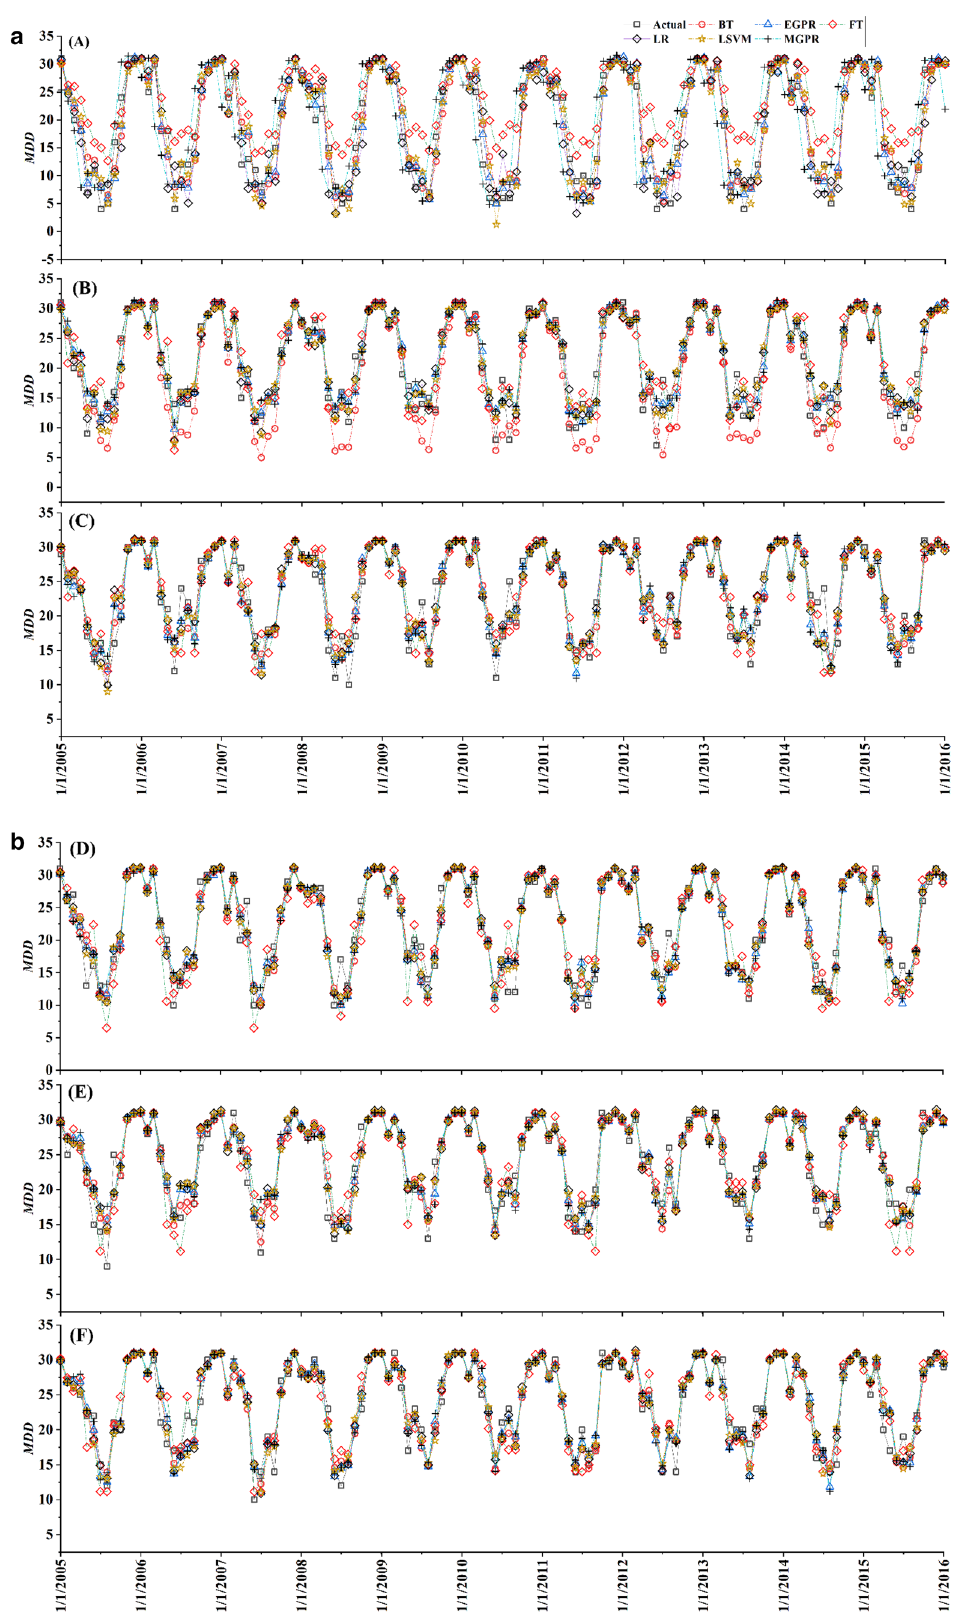
Figure 2. ( a ) Actual and predicted MDD using all ML models when targets are: A = Sylhet, B = Srimangal, C = Rangpur. ( b ) Actual and predicted MDD using all ML models when targets are: D = Mymensingh, E = Dinajpur and F =